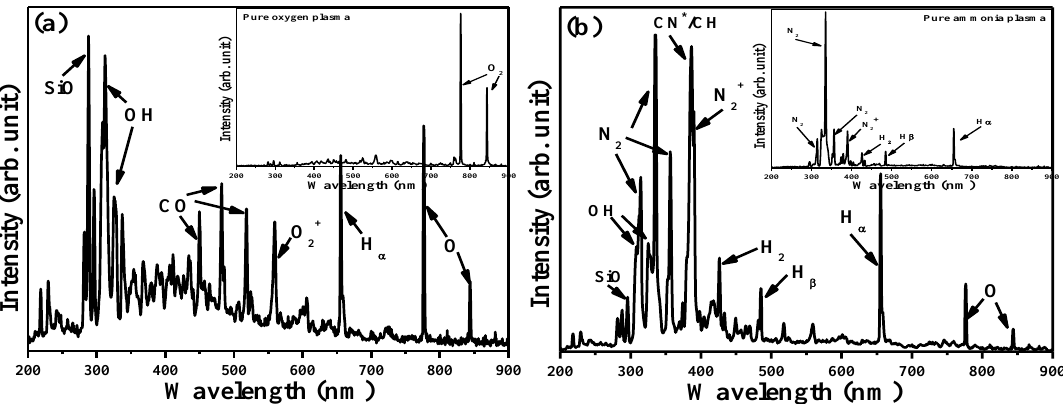
Figure 1. Optical emission spectra (OES) recorded from the glow discharge of the TMS-O 2 -NH 3 gas mixture at an ammonia gas flow ratio of ( a ) 0 and ( b ) 0.5, respectively.